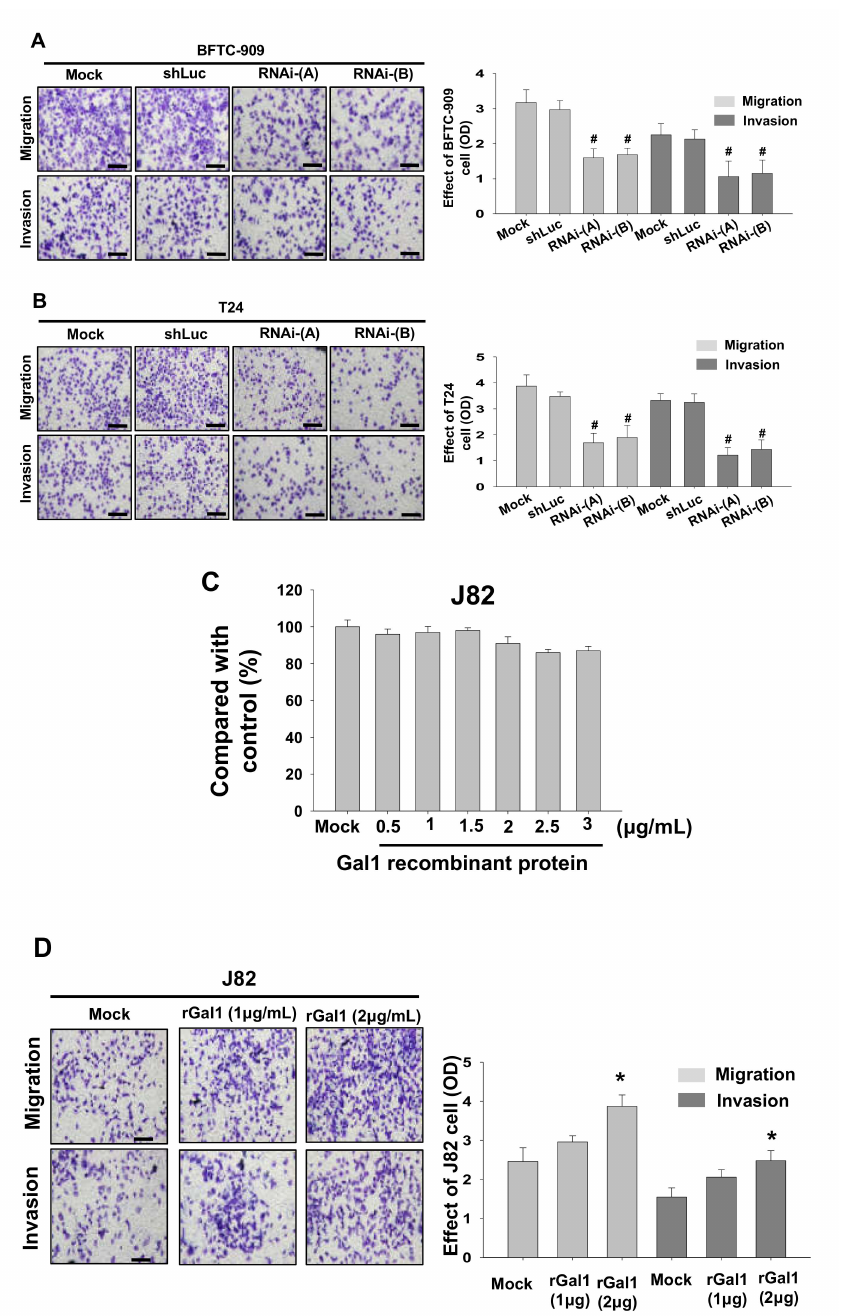
Figure 4. Downregulation of GAL1 a ff ected cancerous behavior in the BFTC-909 and T24 cells and e ff ects of di ff erent concentrations of GAL1 recombinant protein (0–3 µ g / mL) on the J82 cells. GAL1 knockdown cells produced using lentiviruses exhibited a reduction in migration and invasiveness in the BFTC-909 ( A ) and T24 cells ( B ). ( C ) Viability of the J82 cells at di ff erent concentrations of GAL1 recombinant protein (0–3 µ g / mL) after incubation for 24 h. ( D ) After 24 h of treatment with GAL1 recombinant protein (1–2 µ g / mL), the percentages of migration of and invasion by the J82 cells significantly increased compared with the controls (Mock: cells treated with vehicle DMSO). Scale bar = 20 µ m. * p < 0.05, # p <